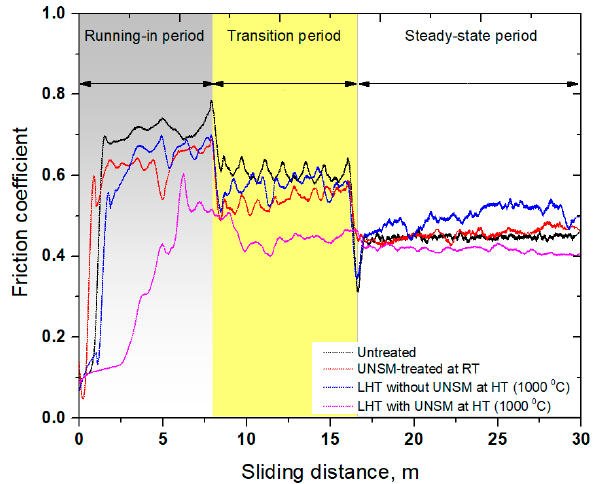
Figure 9. Comparison in friction coefficient with respect to sliding distance of the untreated, UNSM-treated at RT and LHT without and with UNSM treatment at 1000 °C specimens.